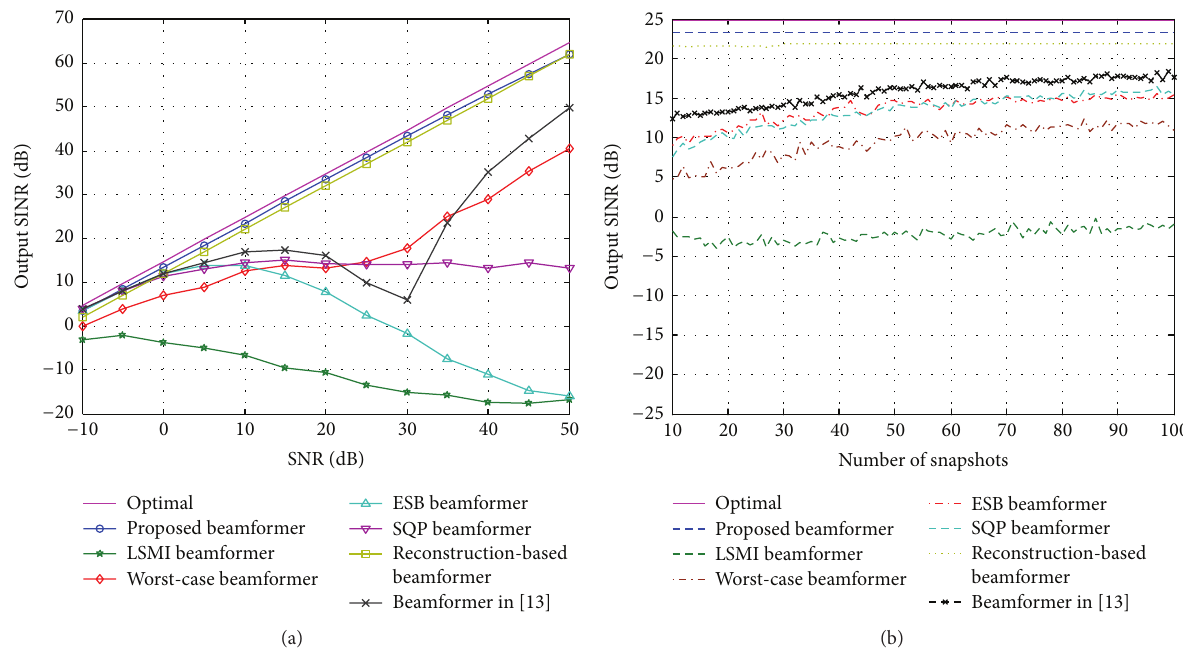
Figure 2: Performance of the beamformers for the case of mismatch due to signal direction error. (a) Output SINR versus SNR for training data size of 𝐾 = 60 and INR = 30 dB. (b) Output SINR versus number of snapshots for fixed SNR = 10 dB and INR = 30 dB.